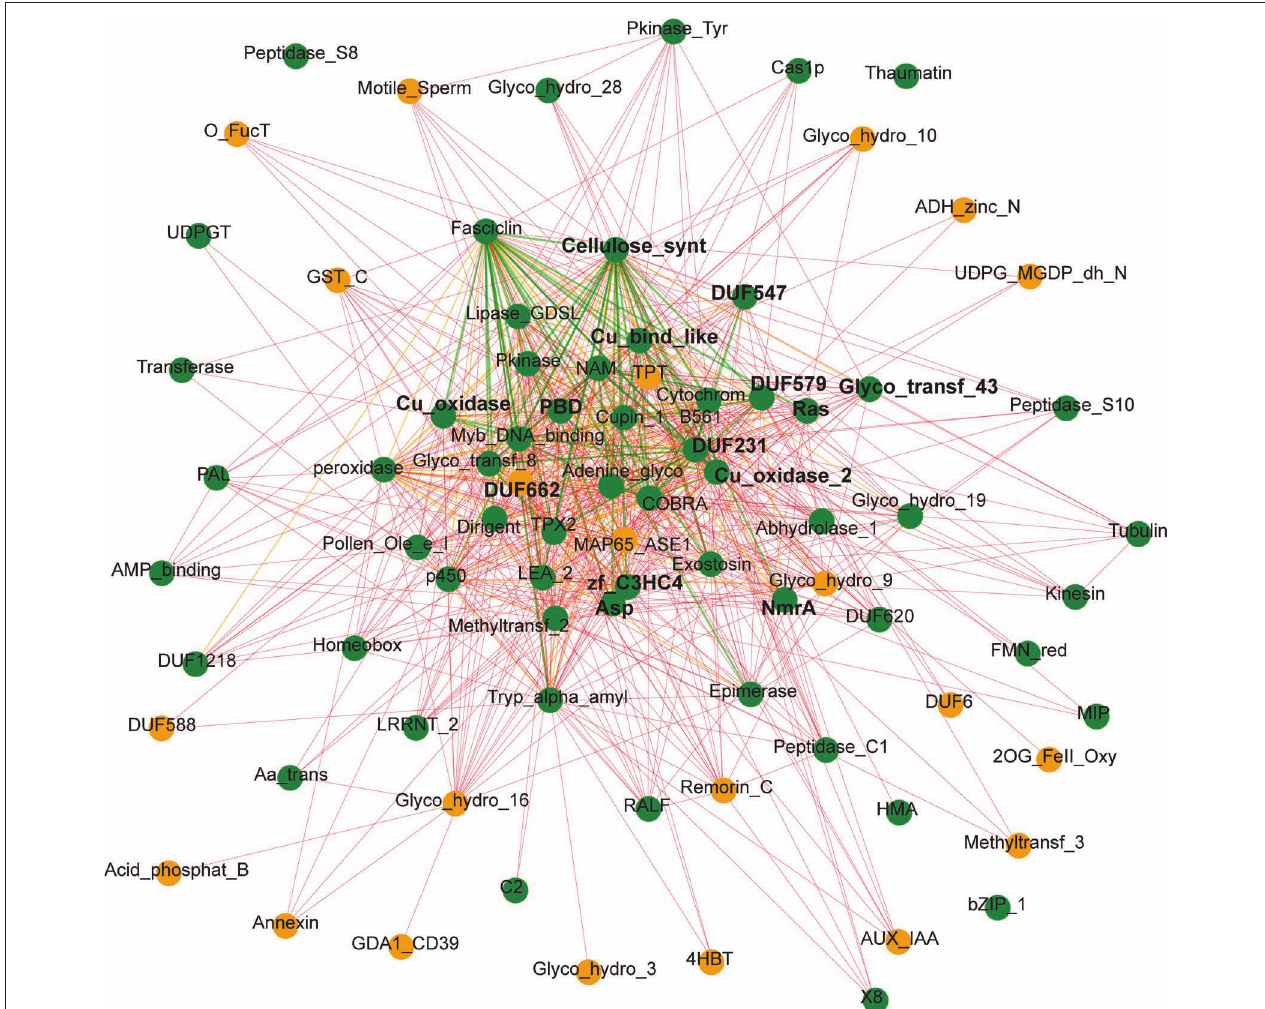
Figure 2 | Consensus co-expression network of secondary cell wall genes from seven plant species. Gene vicinity co-expression networks of the Arabidopsis CESA7 homologs from barley, rice, poplar, medicago, soybean, and wheat were compared for re-occurring gene families (PFAMs). Nodes with their respective PFAM description indicate gene families that are enriched across species. Nodes and edges colored green, orange, and red represent gene families and co-expression relationships between them, that are present in at